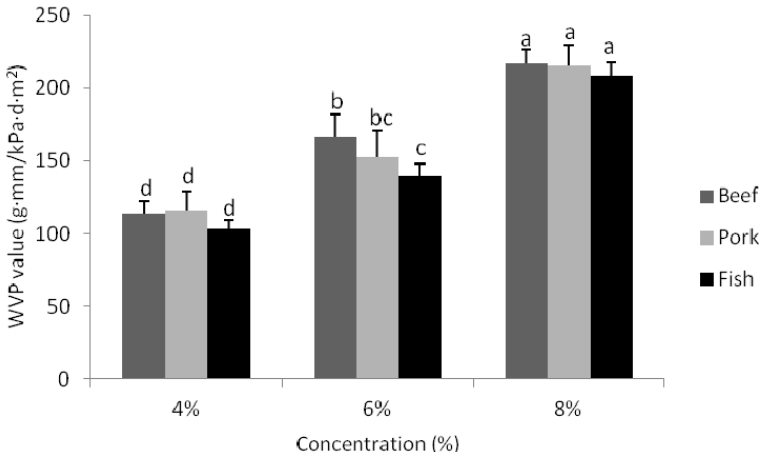
Figure 3. Water vapour permeability values of composite films derived from beef, pork and fish gelatin sources with the concentrations of 4%, 6% and 8%. Error bars represent standard deviations of data with letters indicate significant differences ( p < 0.05) between the WVP